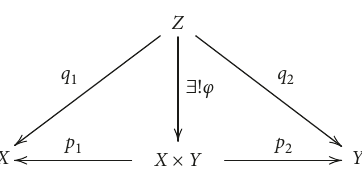
Figure 12: A commutative